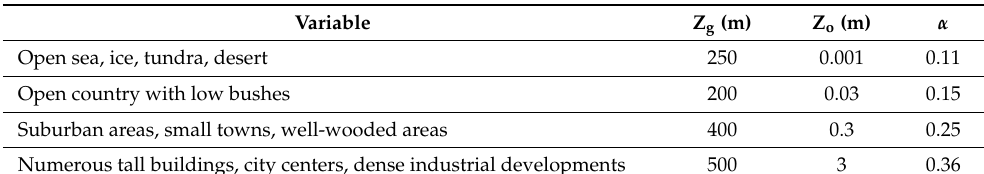
Table 1. Values for the roughness length [39].